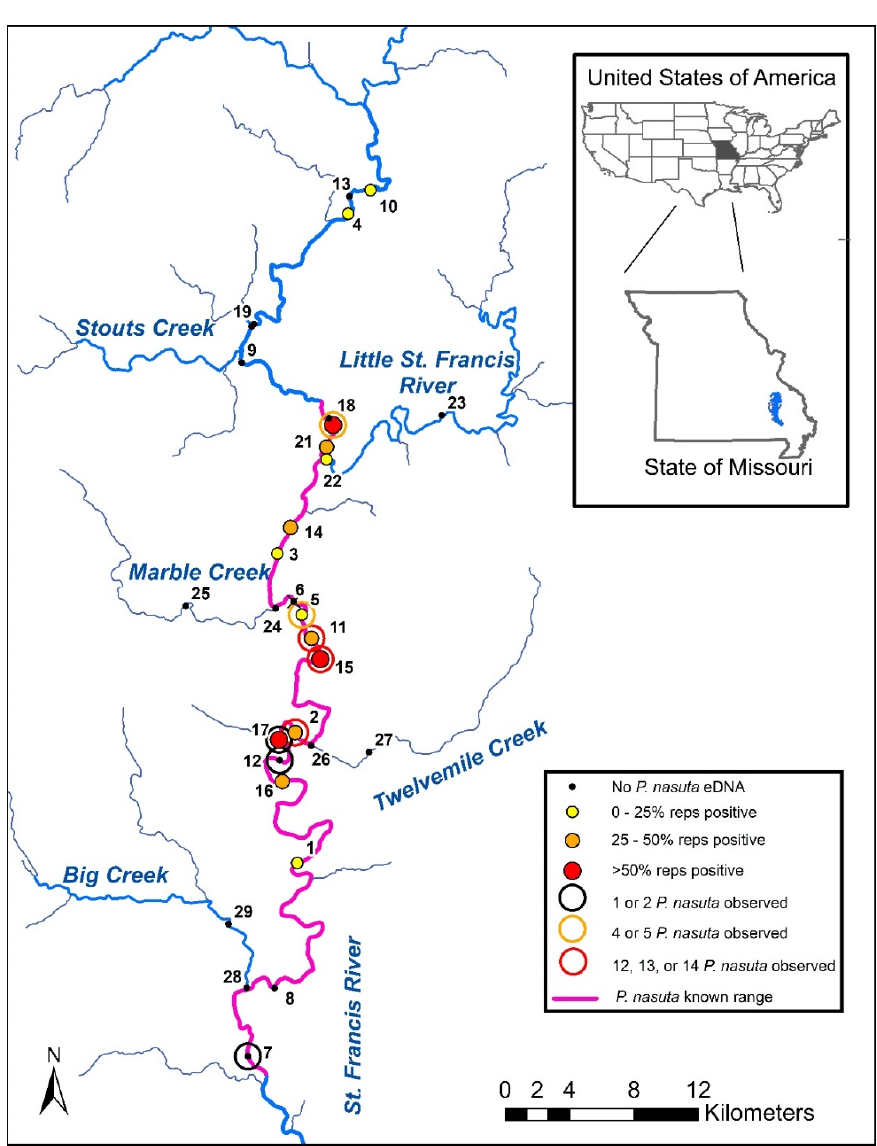
Figure 1. Locations of the 28 sample sites in the St. Francis River drainage of Missouri, including Site 6 which was not sampled. There was no Site 20. Sampling outcomes are indicated by solid circles (eDNA) and open circles (visual surveys). Sites with no eDNA or visual detections are shown as black dots. The prior known range of longnose darter Percina nasuta is shown as a purple line.